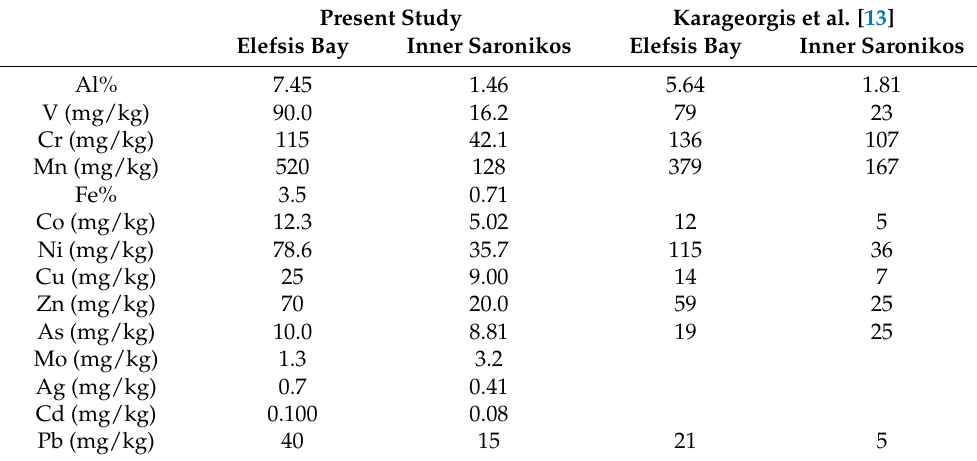
Figure 3. Vertical distribution of metal/Al ratios at the S1, S2, S7, and S11 sampling stations. Table 3. Estimated background concentrations of metals at Elefsis Bay and the Inner Saronikos Gulf.